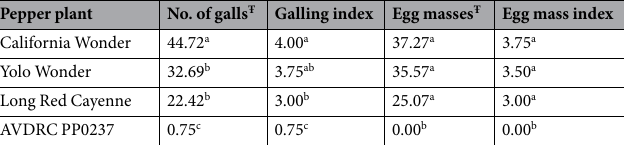
Table 1. Galling and egg-mass indices of California Wonder, Yolo Wonder, Long Red Cayenne and accession AVDRC PP0237. Ŧ Mean number of galls and egg masses per root system of four replicates. Each pot containing five plants was considered as a replicate. Means with different letters in the same column are significantly different (P < 0.05, Duncan’s Multiple Range test). Galling and egg mass indices were done using the scale: 0 = no galls or no egg masses, 1 = 1 to 2, 2 = 3 to 10, 3 = 11 to 30, 4 = 31 to 100, and 5 = more than 100 galls or more than 100 egg masses per plant 22, 54